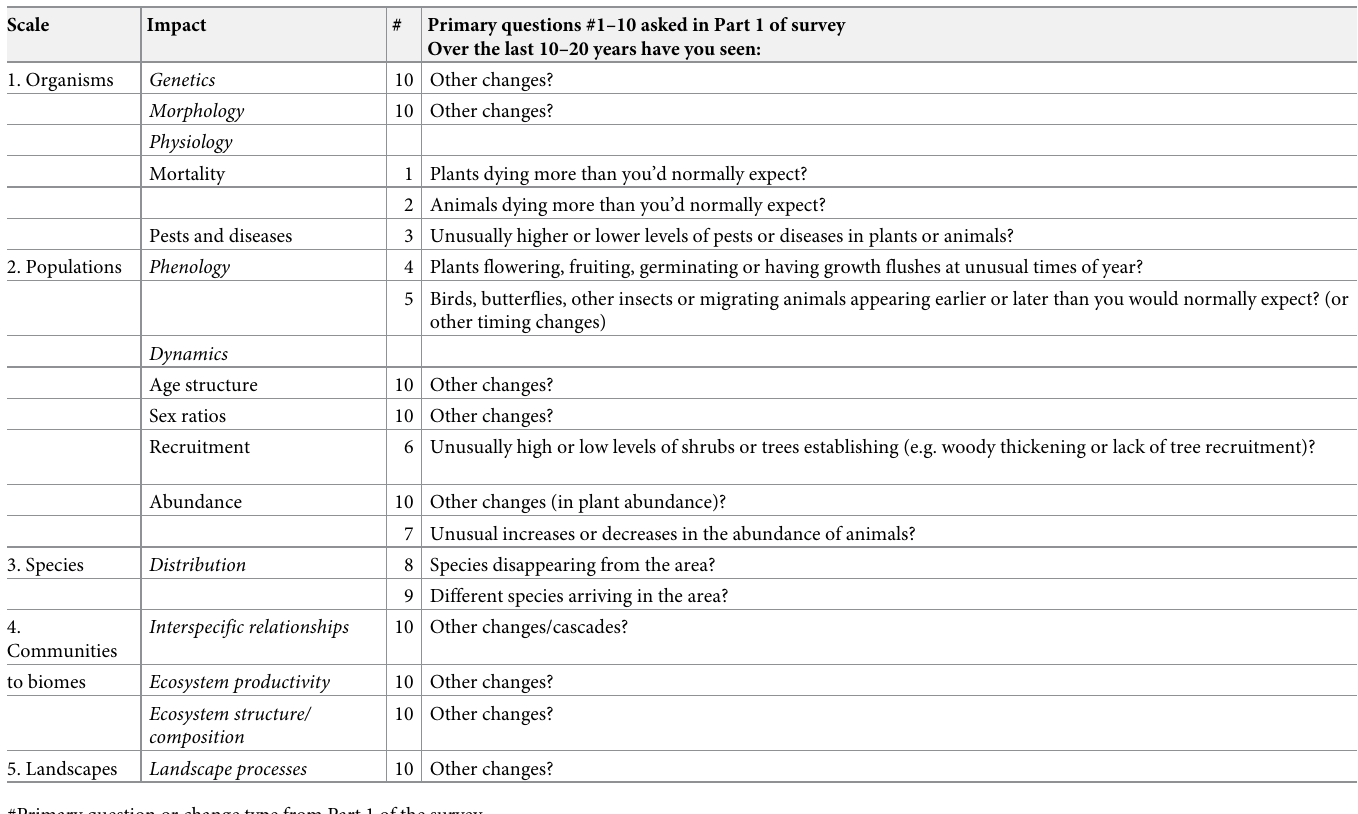
Table 1. Framework used for classifying impacts of climate change on biodiversity from organism to landscape scales [1, 4].